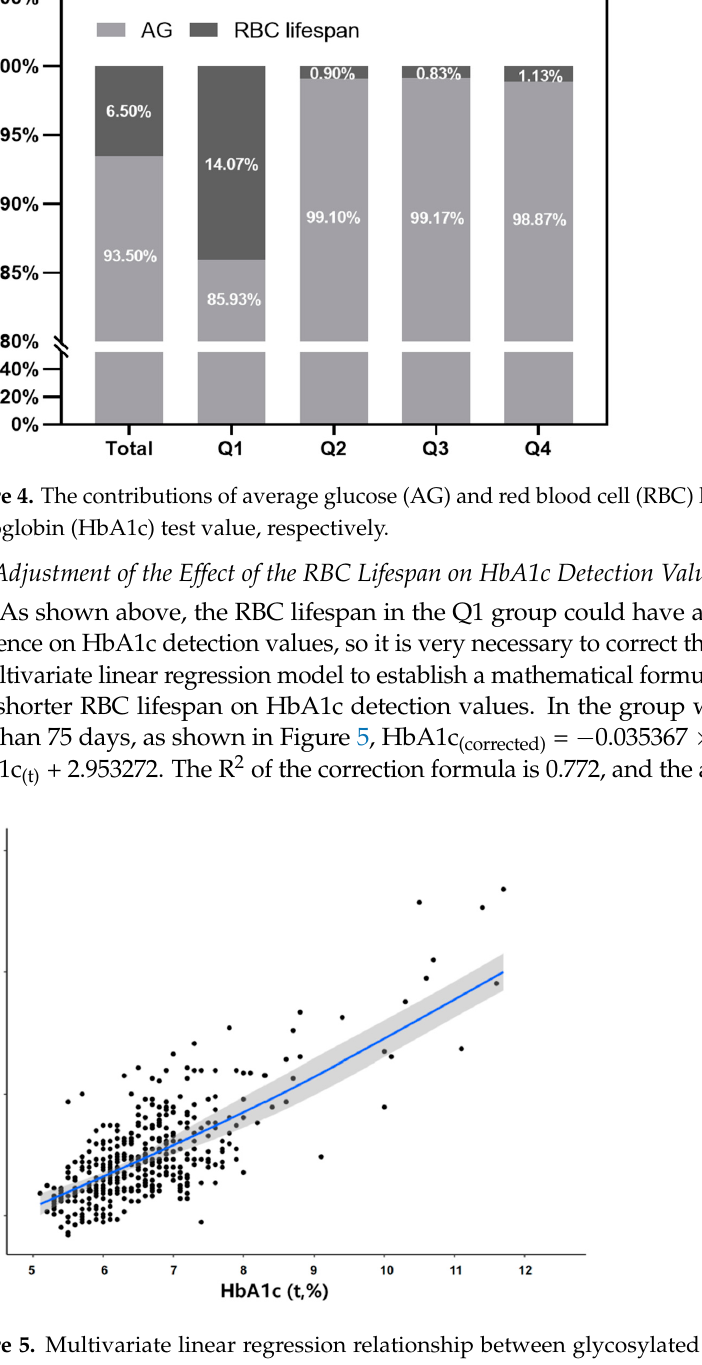
Figure 3. Comparison of average glucose (AG) and glycosylated hemoglobin (HbA1c) among the four groups of patients with type 2 diabetes mellitus (T2DM): ( A ). Comparison of AG among the four groups. ( B ). Comparison of HbA1c among the four groups. * p < 0.1 ** p < 0.01 **** p < 0.0001.